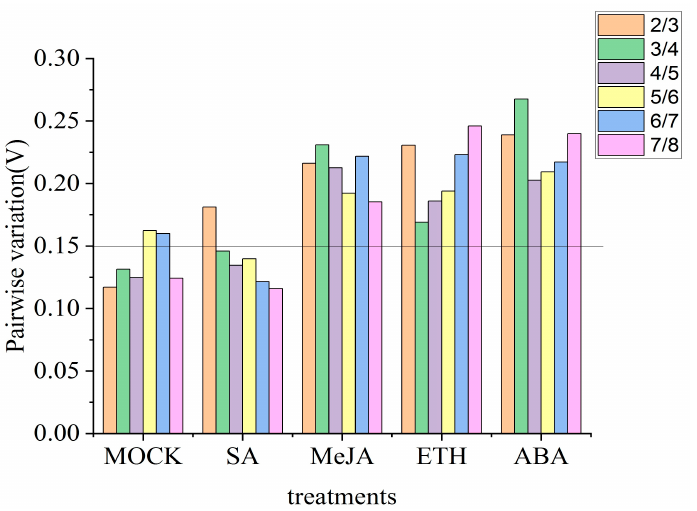
Figure 2. Analysis of reference genes for qPCR normalization using GeNorm in pear leaves under Table 2. Ranking of the expression stability of the eight candidate reference genes in pears under control condition and different hormones. The pairwise variation (V n/n+1 ) in the eight candidate control conditions and hormone treatments with Cq values being calculated using statistical algo- reference genes under different treatments was calculated using GeNorm software, and the opti- rithm software. mal number of reference genes was determined using the lowest number of genes with a V n/n+1 value smaller than